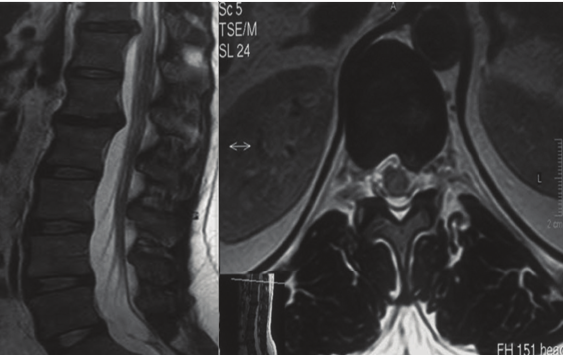
Figure 2: The patient has two distinct degenerative disc diseases in the spine. The rest of the vertebral column has no problem.